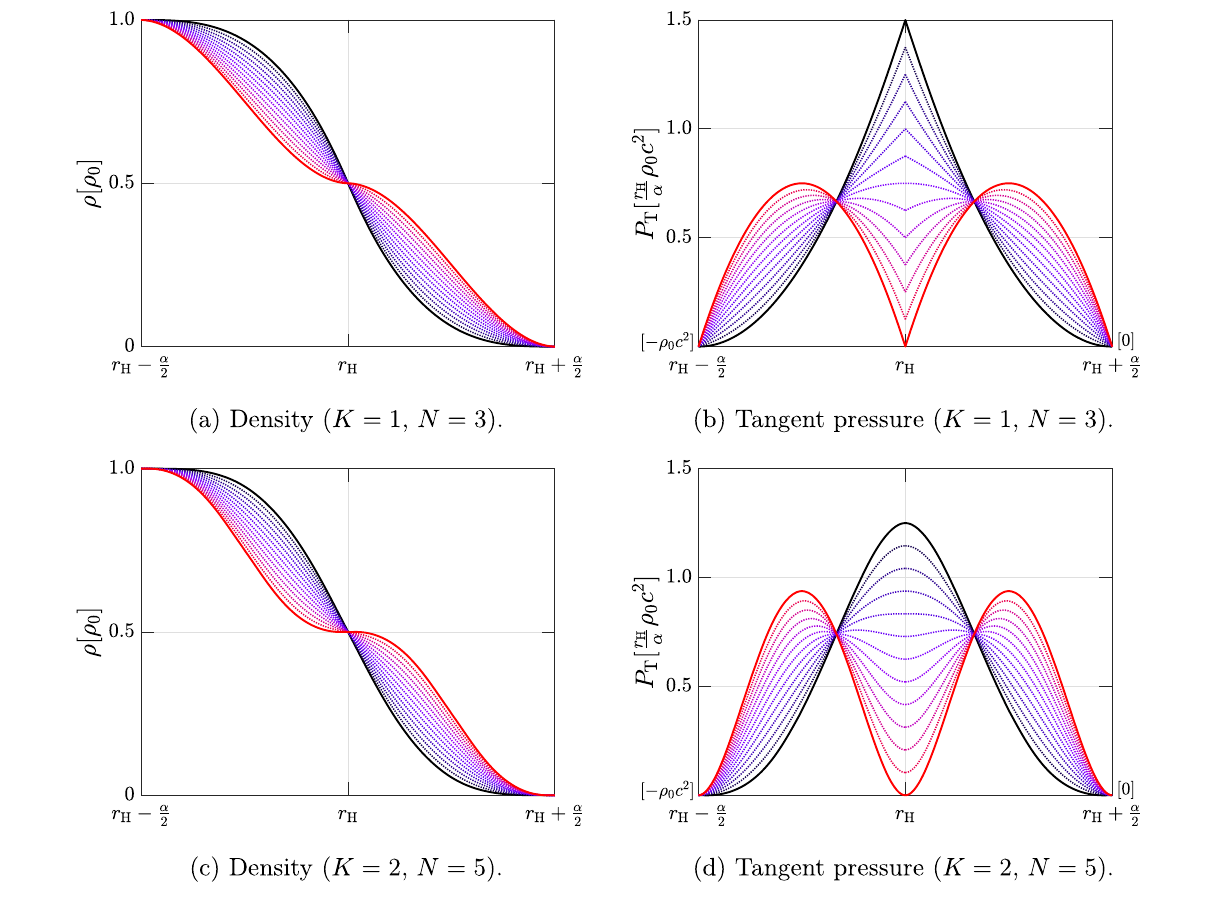
Fig. 1 The cosmological black hole spectrum of density (8) and tan- gential pressure (7) inside the α -shell, that designates the horizon. The values of P T on the boundaries are mentioned separately in brack- ets, because the scaling does not allow them to be distinguished opti- cally. The value of the radial pressure is P r ( r ) = − ρ( r ) c 2 every- where. Exterior to the horizon, ρ , P T are zero and in the interior P T = − ρ c 2 = − ρ 0 c 2 = const. Each curve in all panels represents a solution of the Einstein equations with the same energy and entropy.